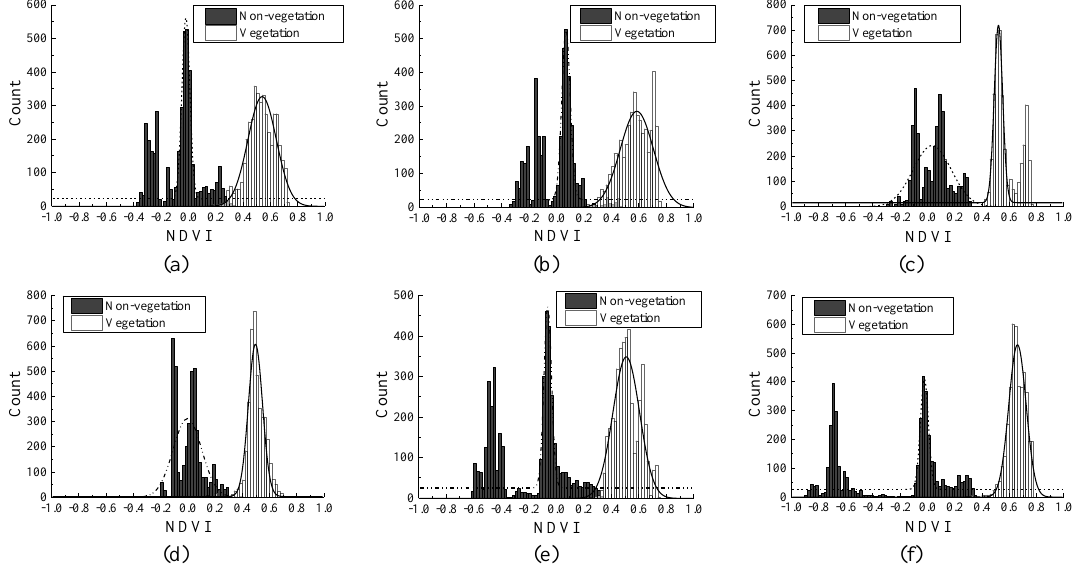
Figure 6. Histogram of NDVI on ( a ) 03/12; ( b ) 03/17; ( c ) 03/25; ( d ) 03/28; ( e ) 04/02; and ( f ) 04/10 for vegetation types and non-vegetation types.